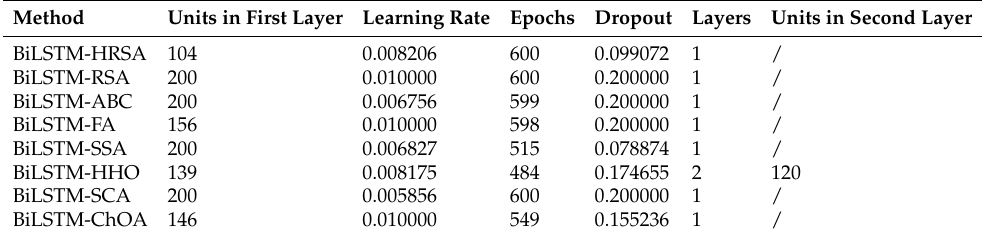
Table 8. Best attained collection of BiLSTM parameter values by each observed algorithm. Method